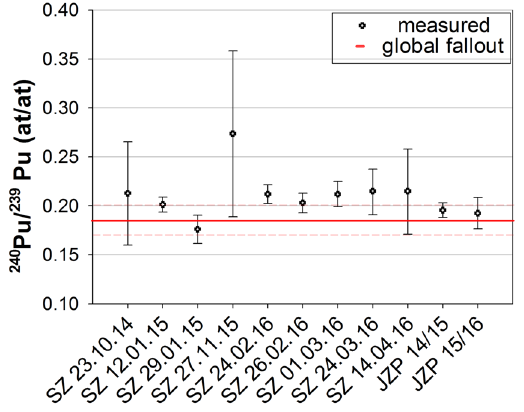
Figure 3. Atomic ratio 240 Pu/ 239 Pu for the snow samples and value of global fall in middle Europe 47 (red line). The error bars indicate expanded uncertainty (k = 2). SZ: freshly fallen snow Zugspitze, JZP: naturally accumulated snow.